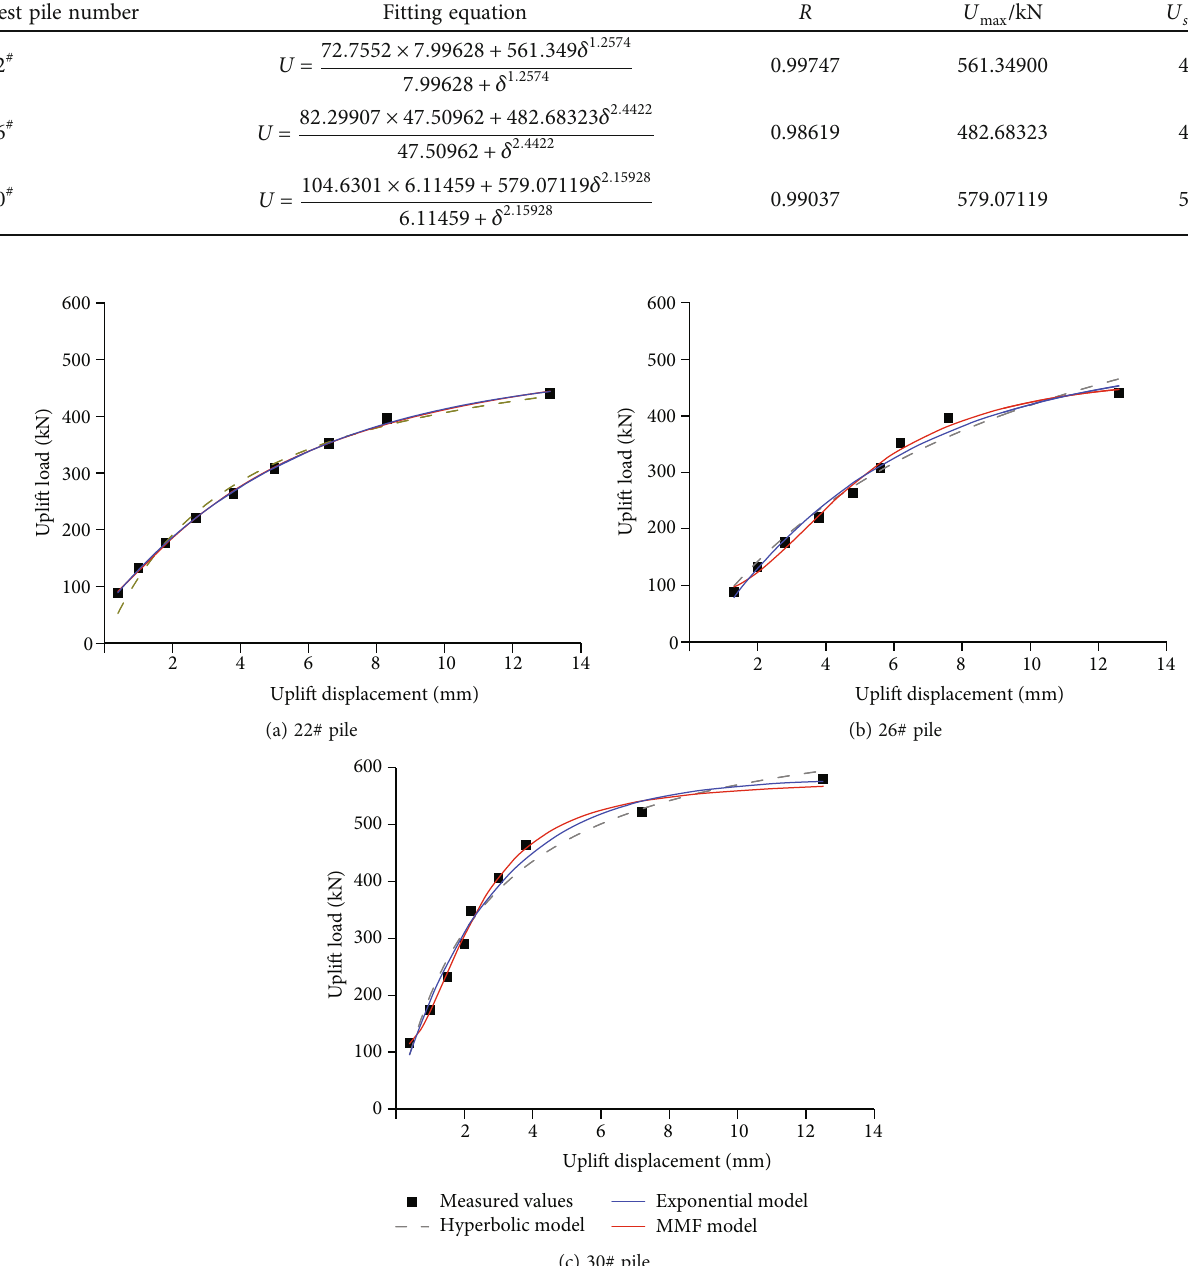
Table 2: Ultimate bearing capacity forecasted for